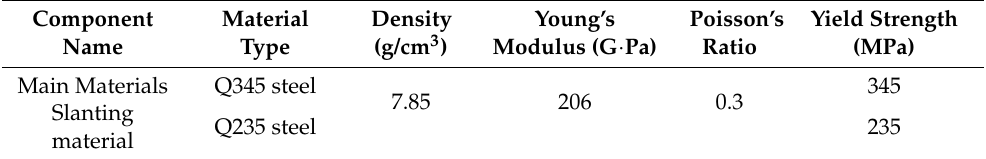
Table 1. Tower main material and slant material related